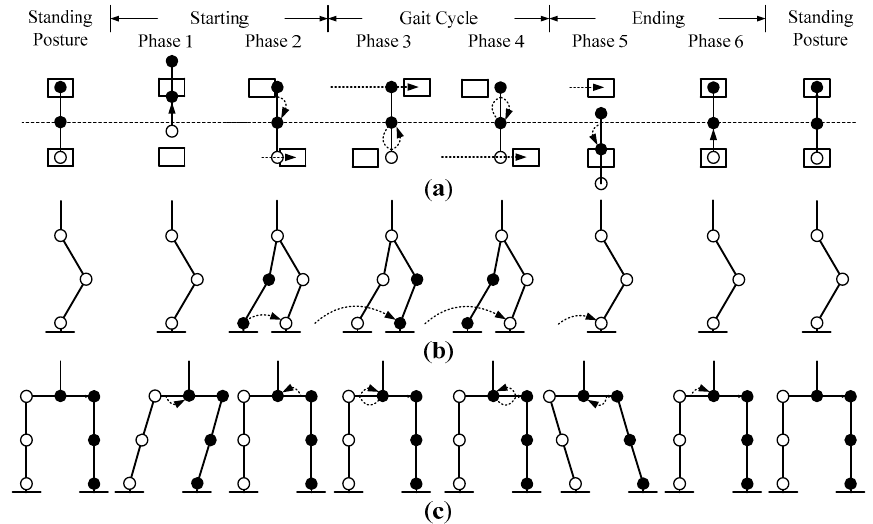
Figure 12. A complete walking process showing the three modes and six phases: ( a ) horizontal plane; ( b ) sagittal plane; ( c ) frontal plane.